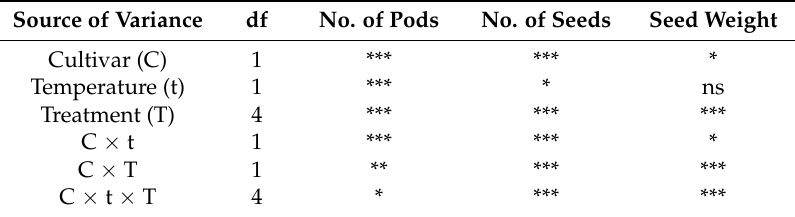
Table 7. Effects of temperature and pre-sowing seed treatment on the number of pods, seeds and seed weight per plant of two L. angustifolius cultivars grown for the first four weeks at 7 ◦ C or 13 ◦ C from seeds germinated in water, three-hour hydroprimed or treated with 10 − 6 M, 10 − 5 M, 10 − 4 M butenolide. Source of Variance df No. of Pods No. of Seeds Seed Weight Cultivar (C) 1 *** *** * Temperature (t) 1 *** * ns Treatment (T) 4